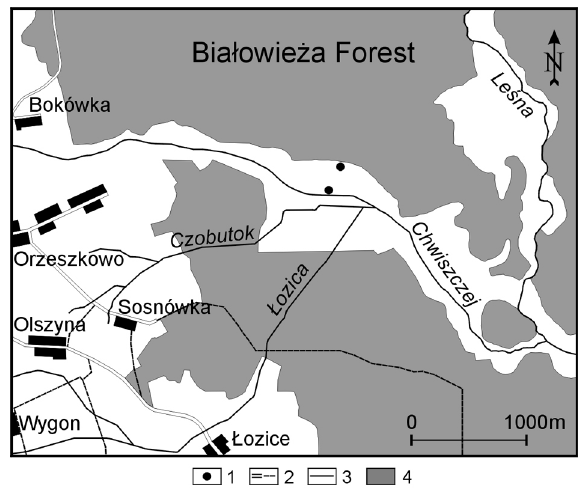
Fig. 1. Location of the study site on the basis of topographic map at 1:50,000 scale (1983). 1 – investigation plots, 2 – roads, 3 – rivers and drainage ditches, 4 –